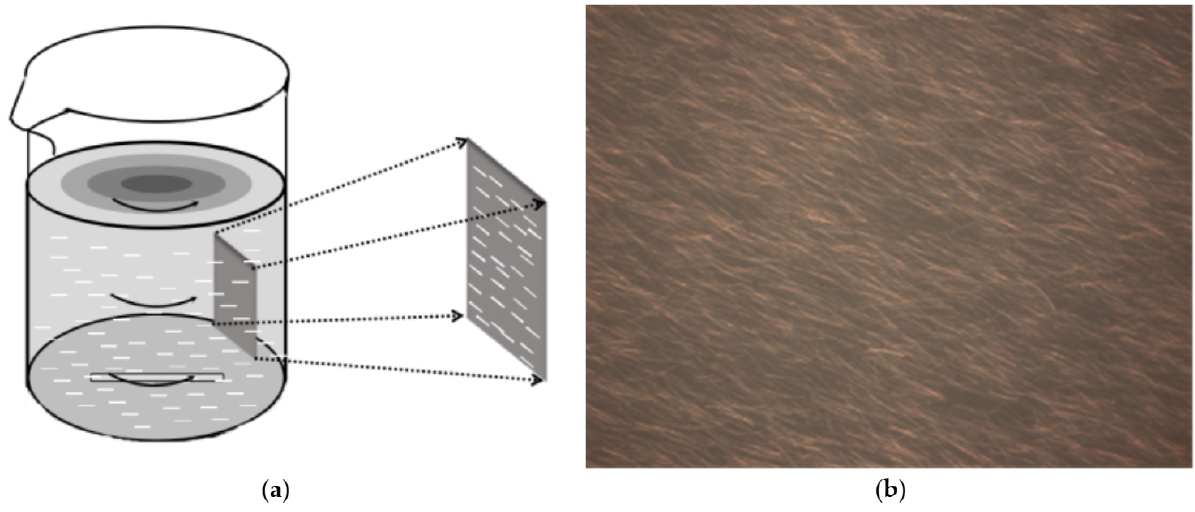
Figure 2. ( a ) Schematic diagram of mixing assisted AgNW assembly—the beaker diameter was 5 cm and the rotating speed was 400 r/min. ( b ) Optical microscope images of uniaxial AgNW